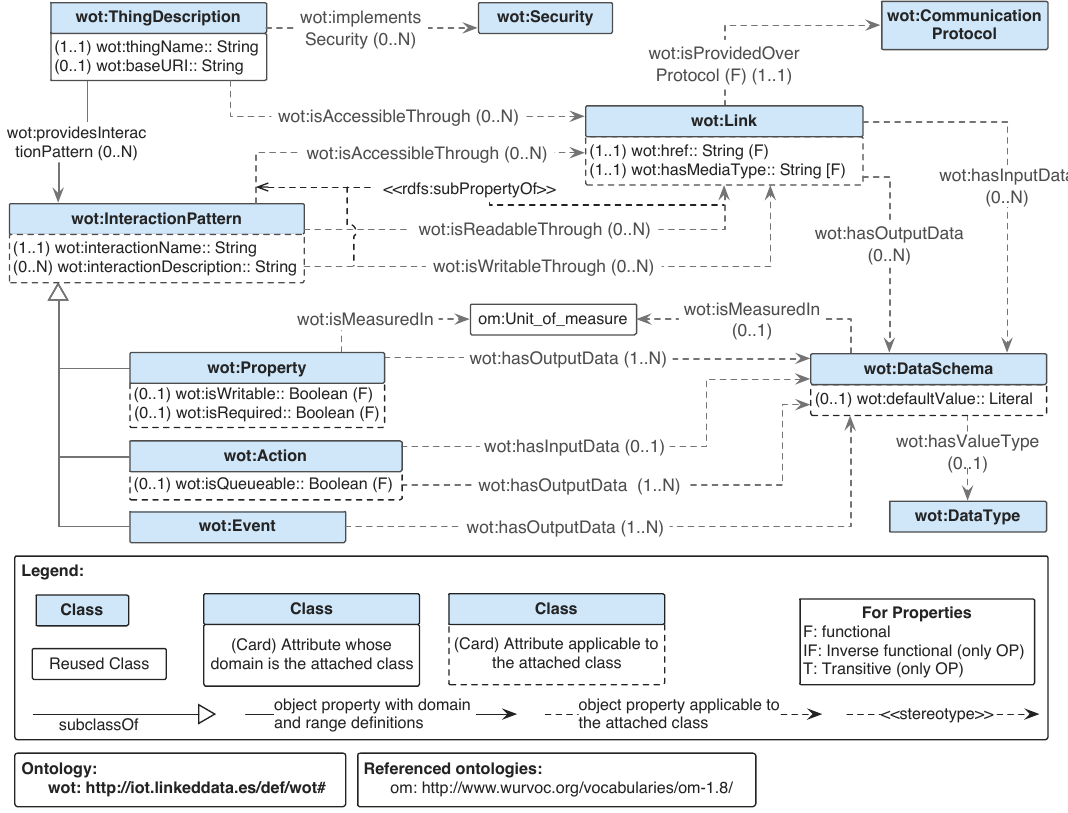
Figure 1. Graphical description of the Web of Things (WoT)